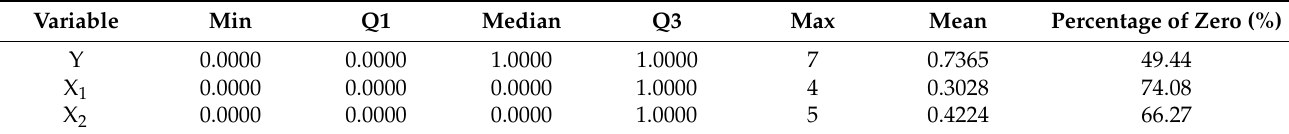
Table 2. Summary statistics of simulation data.